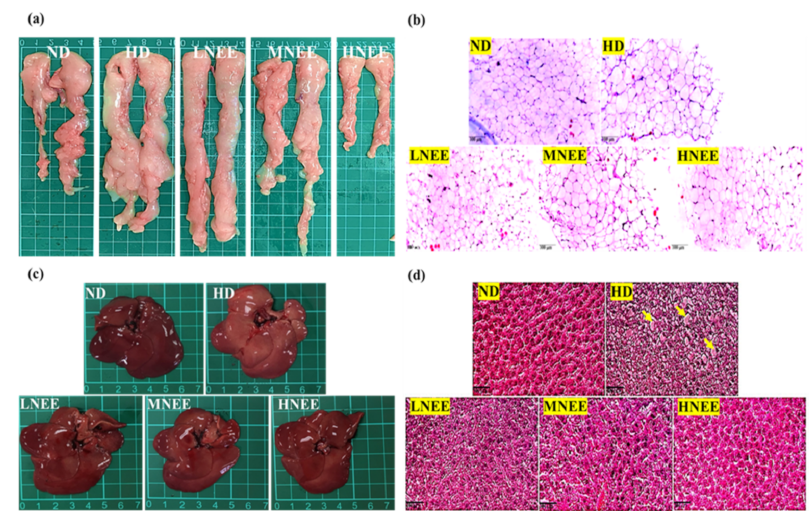
Figure 5. Effects of NEE on epididymal adipose tissue and liver histology in high calorie diet–induced obese rats. Observation of obese rat epididymal adipose tissue ( a ) and liver ( c ), with histological tissue slices in ( b ) and ( d ), respectively, caused by a high-fat diet. Hepatic lipid droplets are shown by the yellow arrowheads ( d ). Hematoxylin and eosin-stained histological tissue slices were examined using a microscope (400 × ). The group names are defined in Table 2 legend.